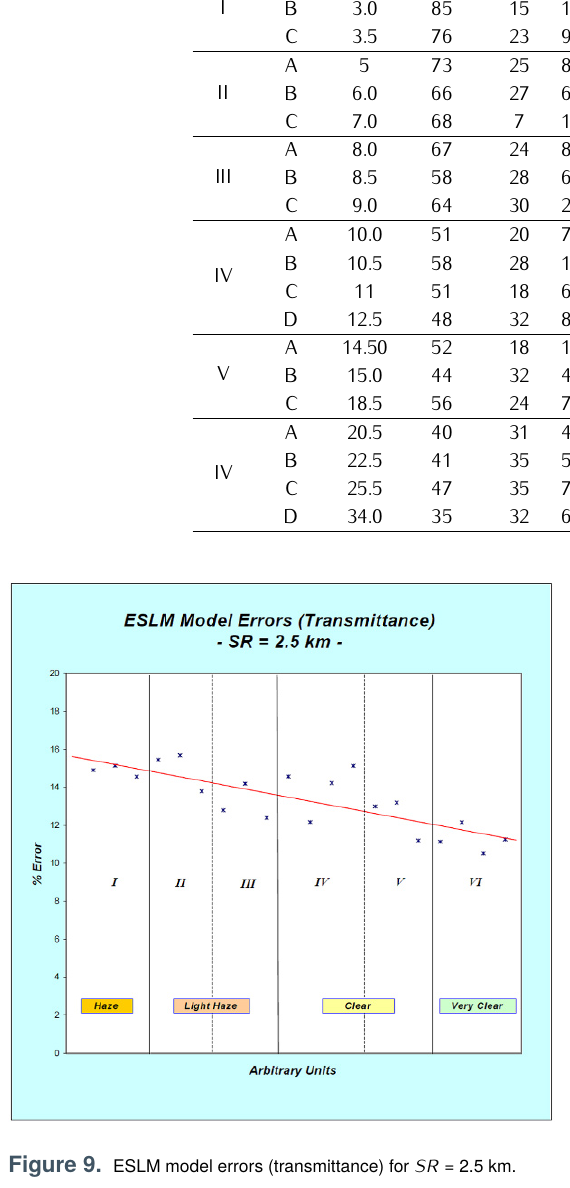
modular target and the laser system positioned along the target normal at a distance of 2.5 km, 4 km and 5.5 km. The target Mean Sea Level (MSL) altitude was about 500 m and the maximum altitude difference between the laser transmitter and the target was about 140 m at a distance of 5.5 km. The geometry of the λ = 1064 nm propagation tests performed at the range are shown in Figure